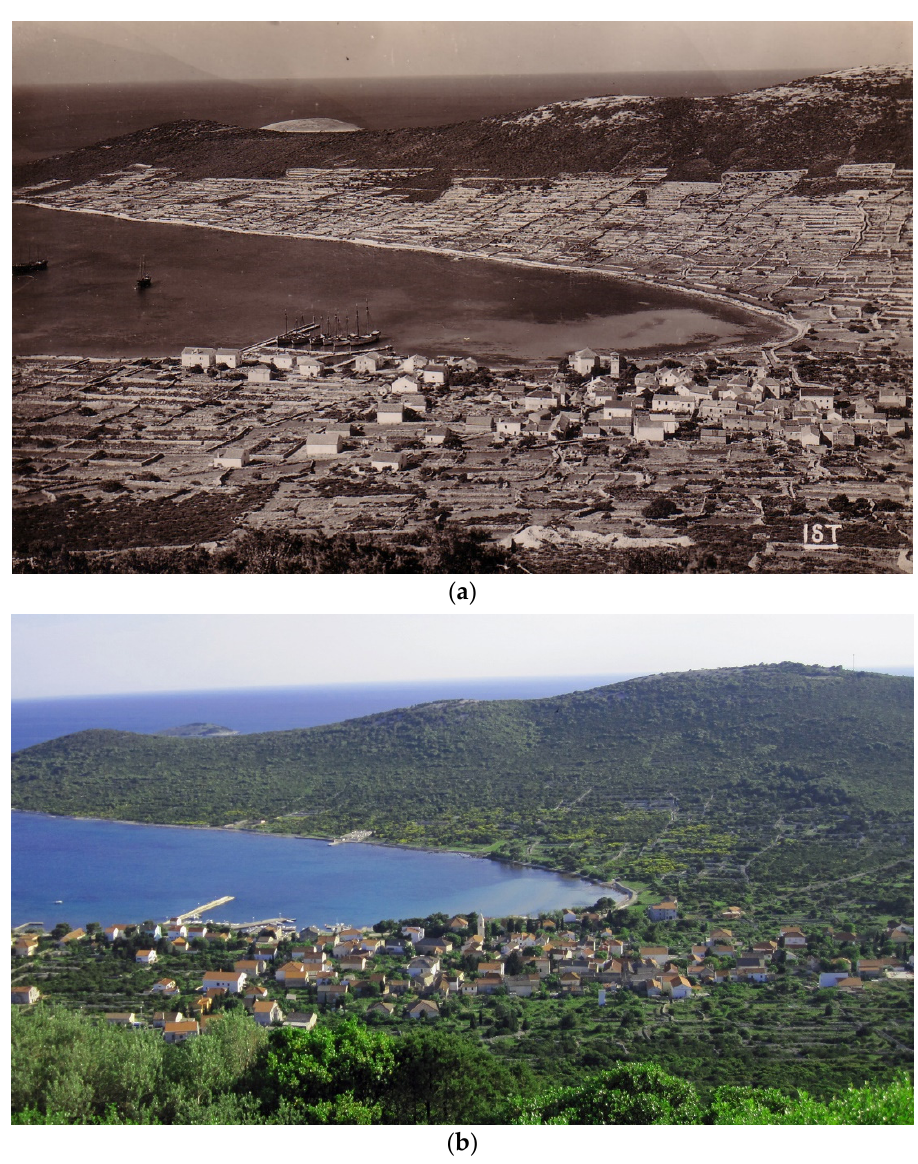
Figure 3. The changing insular landscape as documented on the island of Ist: ( a ) the island’s land- scape in the early 20th century (family collection of Zvonimir Šuljak); ( b ) the landscape photographed in 2010.